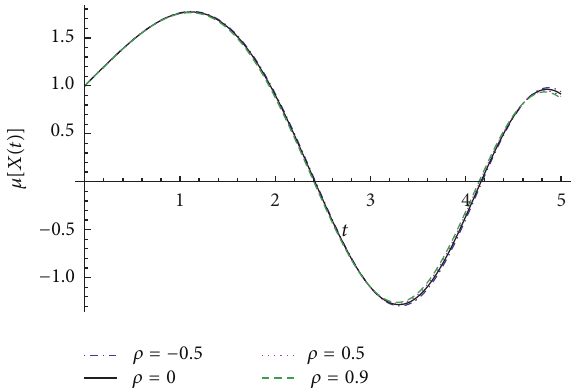
Figure 1: Comparison of the approximations for the expectation 𝜇[𝑋(𝑡)] on the time-interval 𝑡 ∈ [0,5] for different correlation ∈ {−0.5,0, 0.5, 0.9} in Example 2 by using values 𝜌 = 𝜌 𝐴,𝑌 0 Fr¨obenius, Polynomial Chaos, and Monte Carlo simulations. Since the numerical values are indistinguishable graphically, for the sake of clarity in the presentation, nonlabel has been introduced. We assume that 𝑌 1 = 1 and 𝜂 = (𝐴, 𝑌 0 ) ⊤ follows a bivariate Gaussian distribution: 𝜂 ∼ 𝑁( 𝜇 𝜂 ; Σ 𝜂 ) where, according to (34), 𝜇 𝐴 = 1 , = 1 , 𝜎 = 0.2 , 𝜎 = 0.2 𝜇 𝑌 0 𝐴 𝑌 0